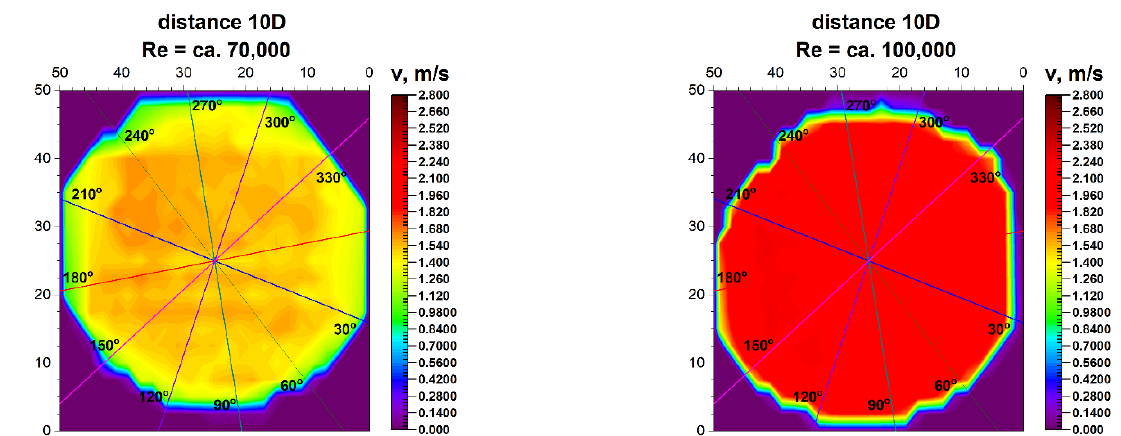
Figure 17. Comparison of projections on the velocity blocks the distances 8D from the disturbance with marked cross- sections for Re ≅ 70,000 and 100,000.